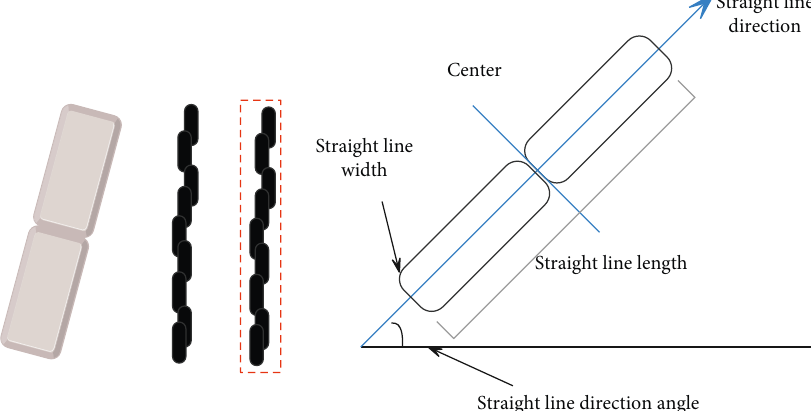
Figure 4: Rectangular approximate schematic diagram of the line segment support